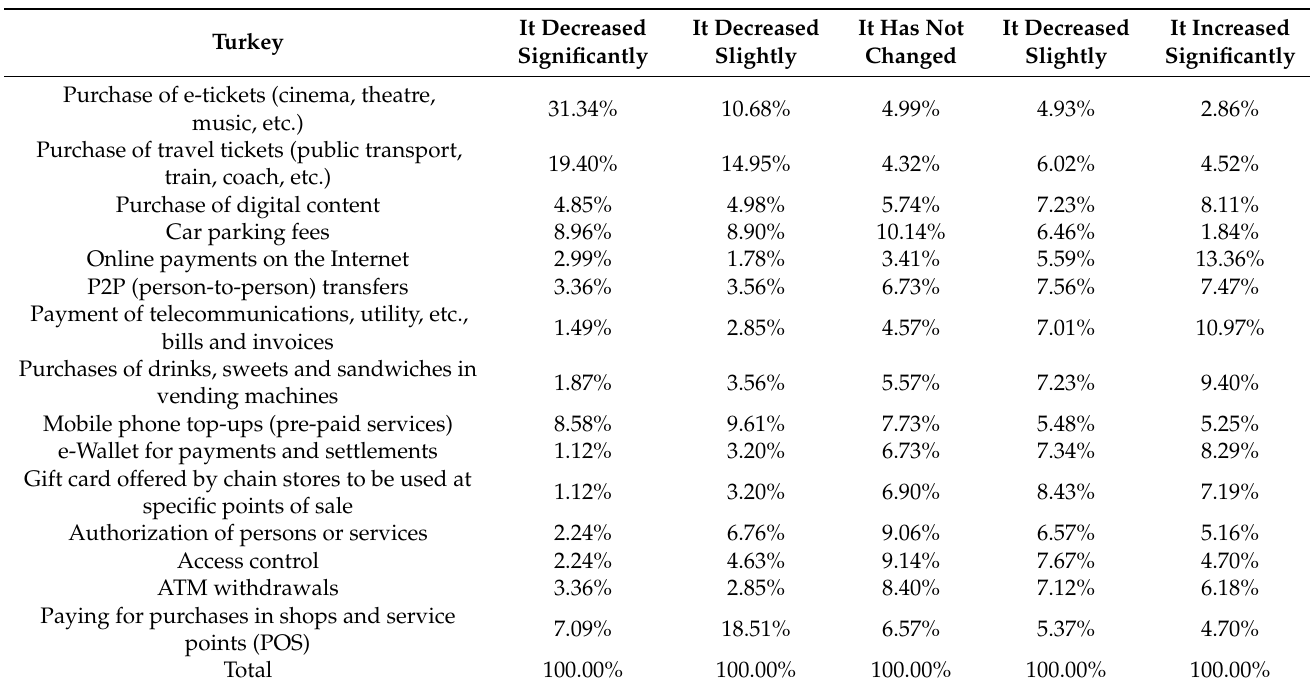
Table 7. The dynamics of changes in mobile payments in Turkey during the pandemic according to selected types of activity; source: own